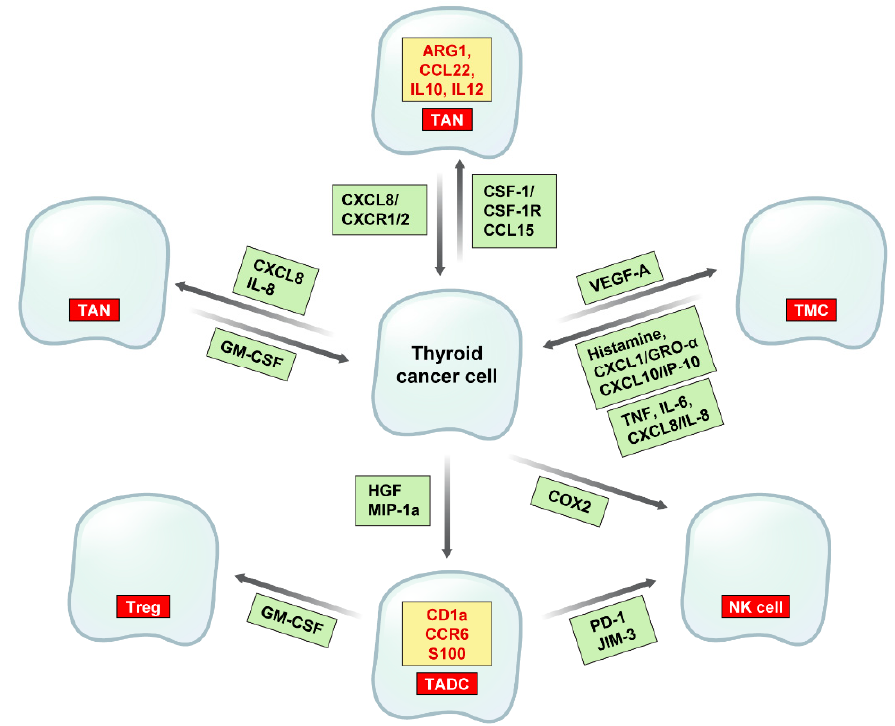
Figure 3. Interaction between cancer cells and immune cells in thyroid cancer. CSF-1 and CCL15 produced by thyroid cancer cells recruit TAM, which produce CXCL8 that binds to CXCR1/2 and promotes tumor progression. TAM in thyroid cancers are M2 types that express ARG1, CCL22, IL10, and IL12. CXCL8 and IL-8 recruit TAN, which produce GM-CSF that is involved in tumor progression. VEGF-A recruits TMC, which produce histamine, CXCL1/GRO- α , and CXCL10/IP-10 that promote cancer cell proliferation. TMC also produce TNF, IL-6, and CXCL8/IL-8 that are involved in EMT. HGF and MIP-1a recruit TADC, which recruit Treg by ICOS, and PD-1 and JIM-3 recruit NK cells. TADC in thyroid cancers express CD1a, CCR6 and S100, and thyroid cancer cells produce COX-2 to recruit NK